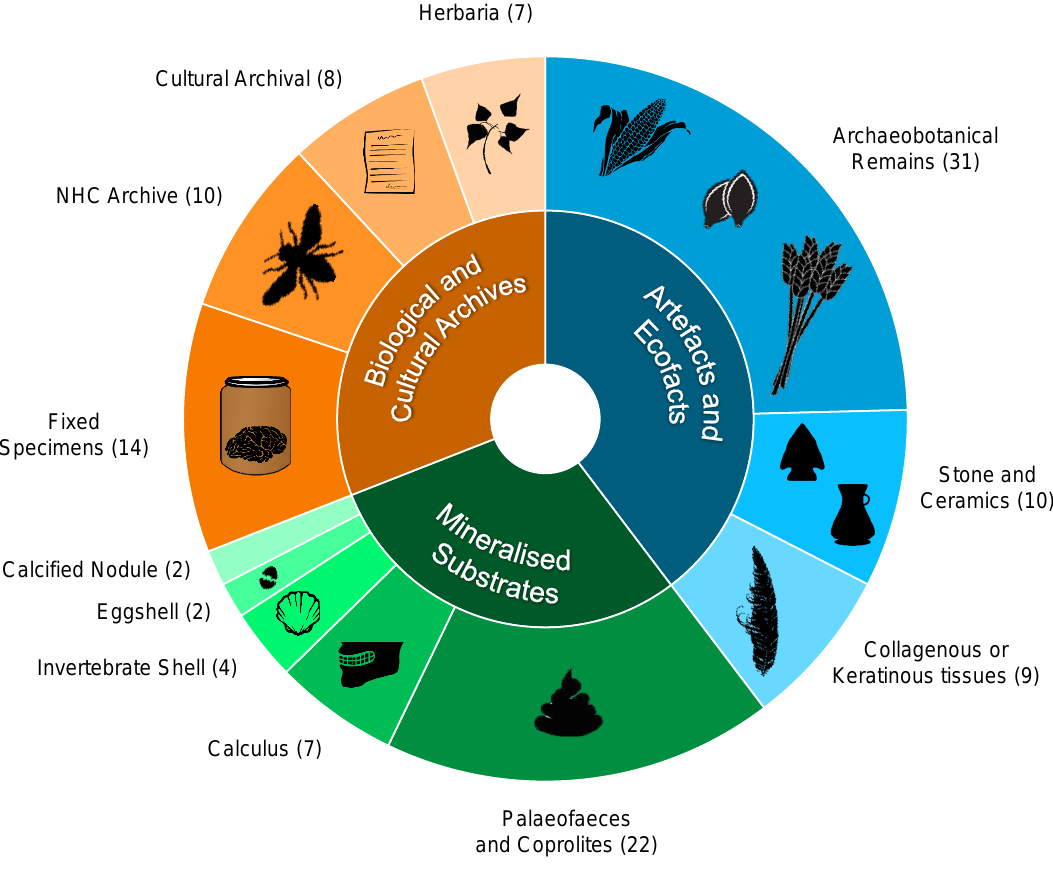
Figure 1. The relative proportion of studies discussed in this review (126 papers from 1988 to May 2017) targeting various alternative substrates for the recovery of ancient DNA. NHC: natural history collections.